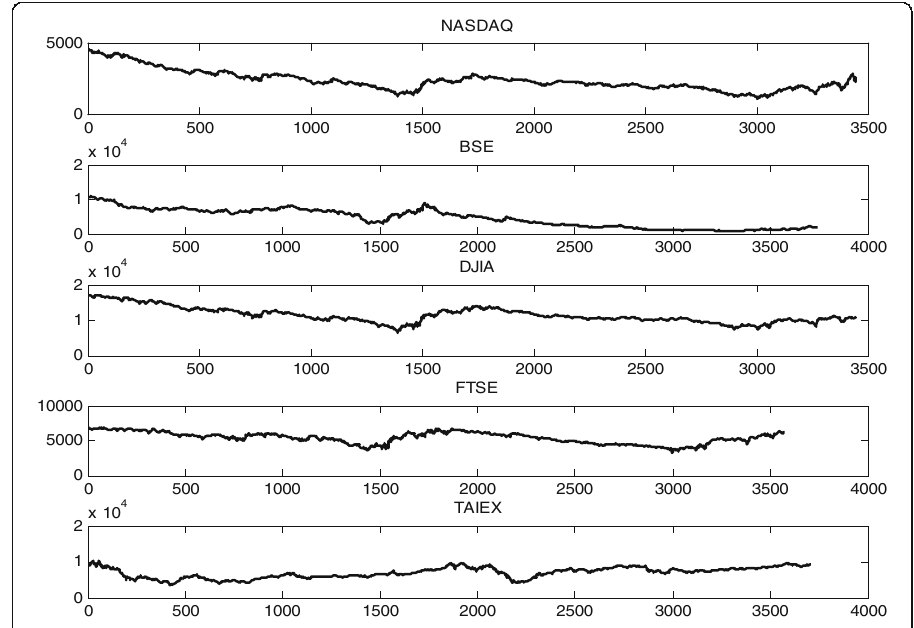
Fig. 6 Daily closing indices of NASDAQ, BSE, DJIA, FTSE, and TAIEX stock market during 01 January 2003